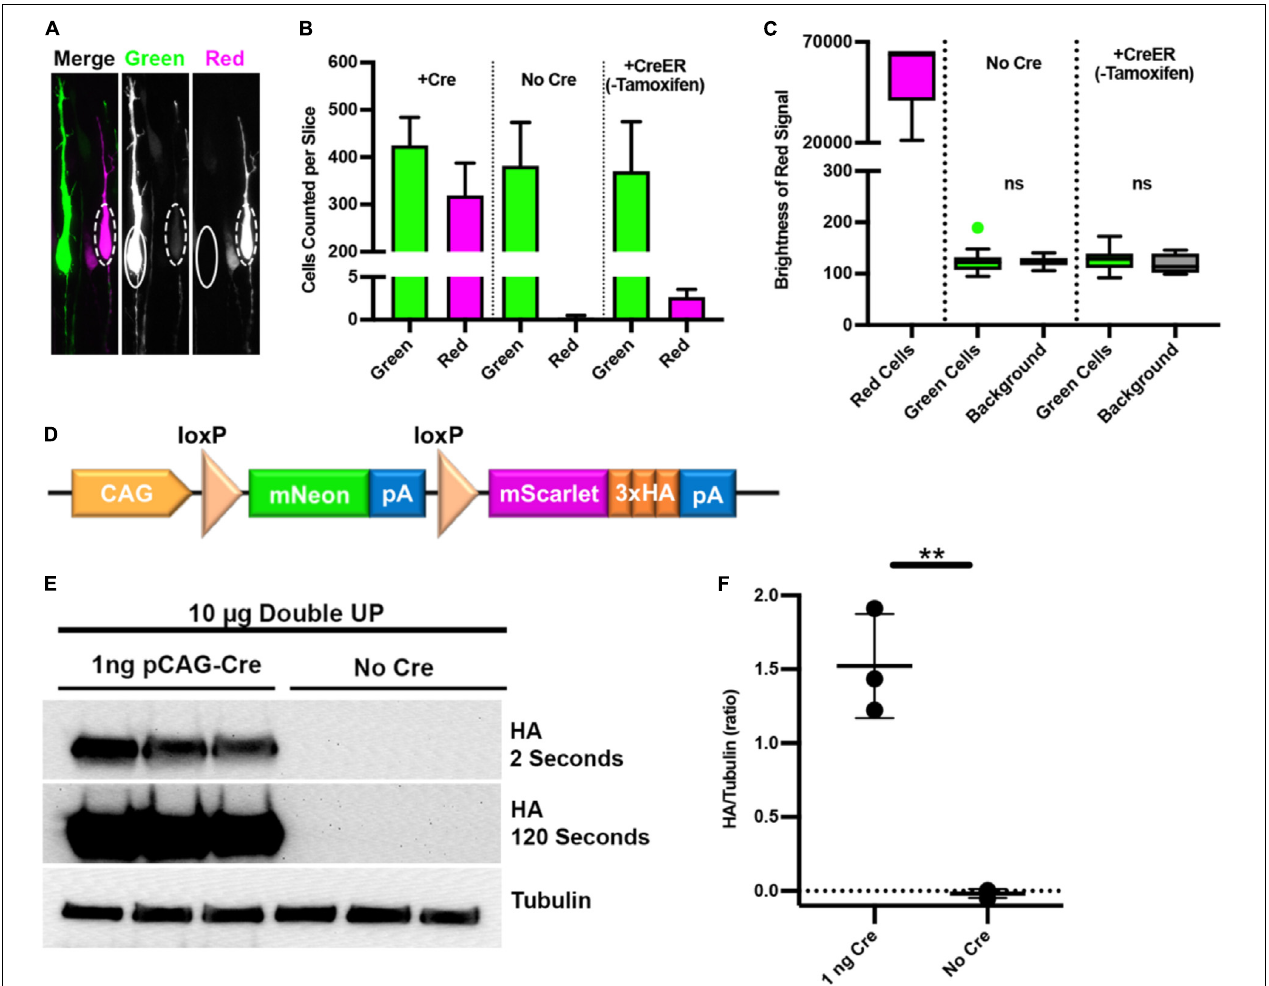
FIGURE 3 | Double UP is not “leaky.” Three tests to determine if green cells express any red protein or associated manipulation. (A) High power image of two adjacent neurons, one green and one red, taken with a 63x/1.4NA oil objective. In the green neuron (solid oval), no signal is visible in the red channel. In the red neuron (dashed oval), a faint signal is visible in the green channel. (B) Number of green and red cells of greater than 1000 units of brightness per slice in Double UP + Cre (three slices, mean = 425 green/320 red cells), Double UP No Cre (four slices, mean = 382 green/0.25 red cells), and Double UP + ERT2-Cre-ERT2 (three slices, mean = 370 green/three red cells). Error bars indicate SEM. All images acquired with identical settings. (C) Quantification of the brightness in the red channel of red neurons from 90 neurons across three brains for: red neurons from Double UP + Cre, as well as green neurons from brains having received Double UP without Cre and Double UP + CreER. Dot above box and whiskers in “Green Cells” column with No Cre indicate an outlier. All other points are contained within the whiskers (Tukey). Boxes are 25/75%, median is also shown. (D) Schematic of Double UP-HA. (E) Western blots of protein from CAD cells transfected with 10 µ g of Double UP and either 1 ng/ µ L pCAG-Cre or no Cre. Quantification done on HA exposed for 2 s, 120 s exposure only shown for reference. (F) Amount of HA protein detected in each condition. The average HA signal in three experiments was slightly less than background. ** p = 0.0017, unpaired two-tailed t -test of three experimental replicates. Lines indicate mean and